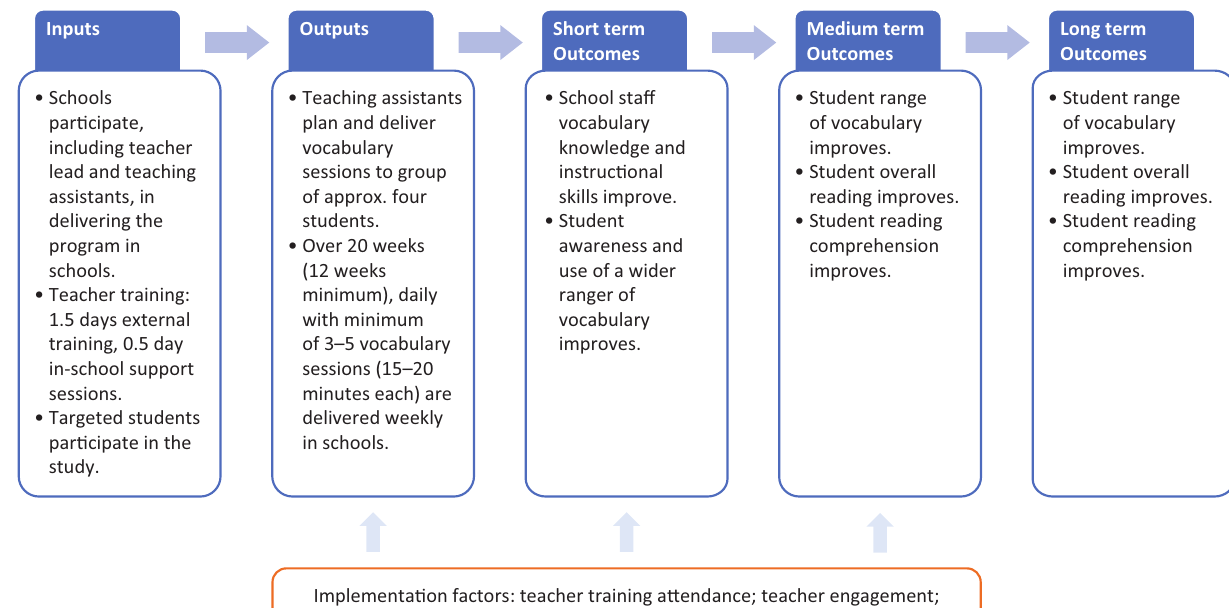
Figure 1. Vocabulary program logic